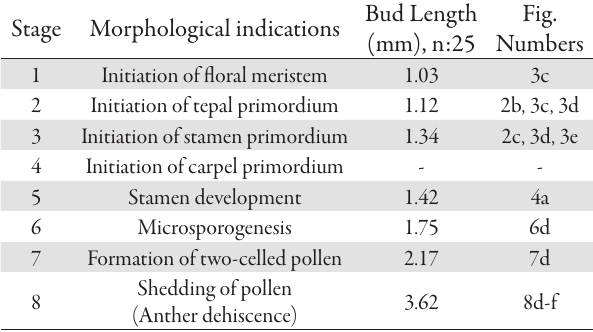
Tab. 1. Morphological indications and respective lengths of floral buds in Laurus nobilis L. at various stages of development Stage